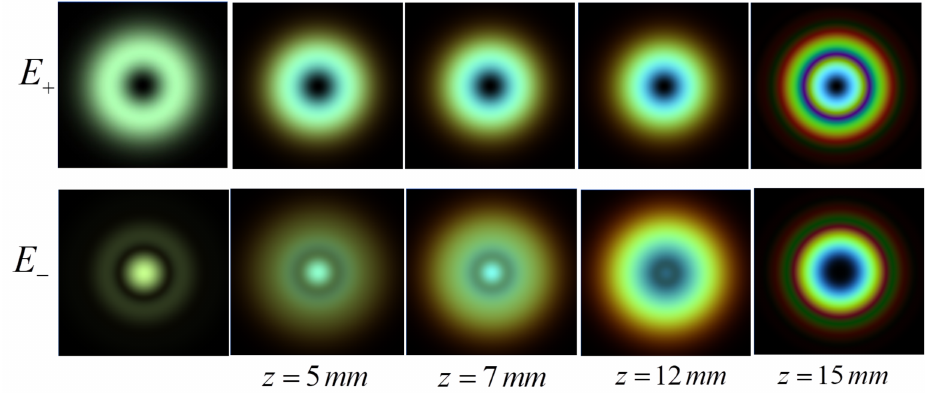
Figure 5. Generation of a polychromatic Laguerre–Gauss beam with n = 1, l = 0 from a poly- chromatic beam with n = 0, l = 2 and in a lithium niobate crystal; image size along the x,y axes (cid:113) 5 w = 5 w 0 1 + ( z / z o ( 0.555 mkm )) 2